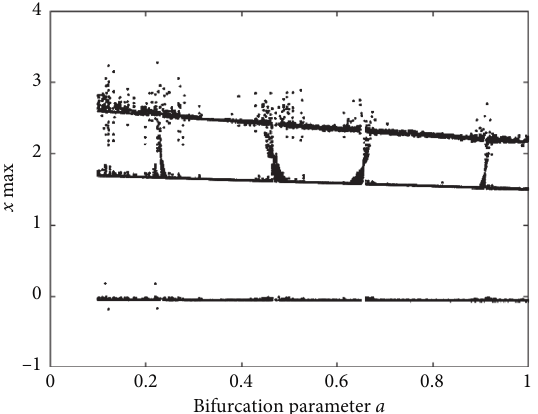
Figure 23: Bifurcation diagram with the variation of the pa- rameter a .